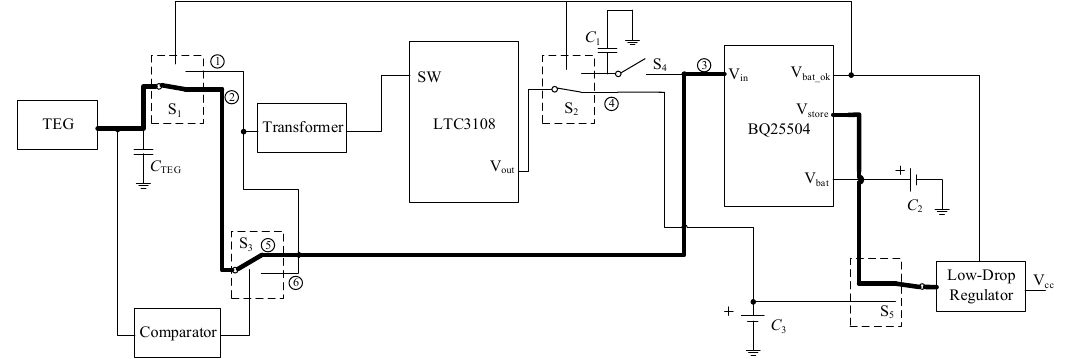
Figure 4. The high temperature gradient period working principle of proposed PMS.